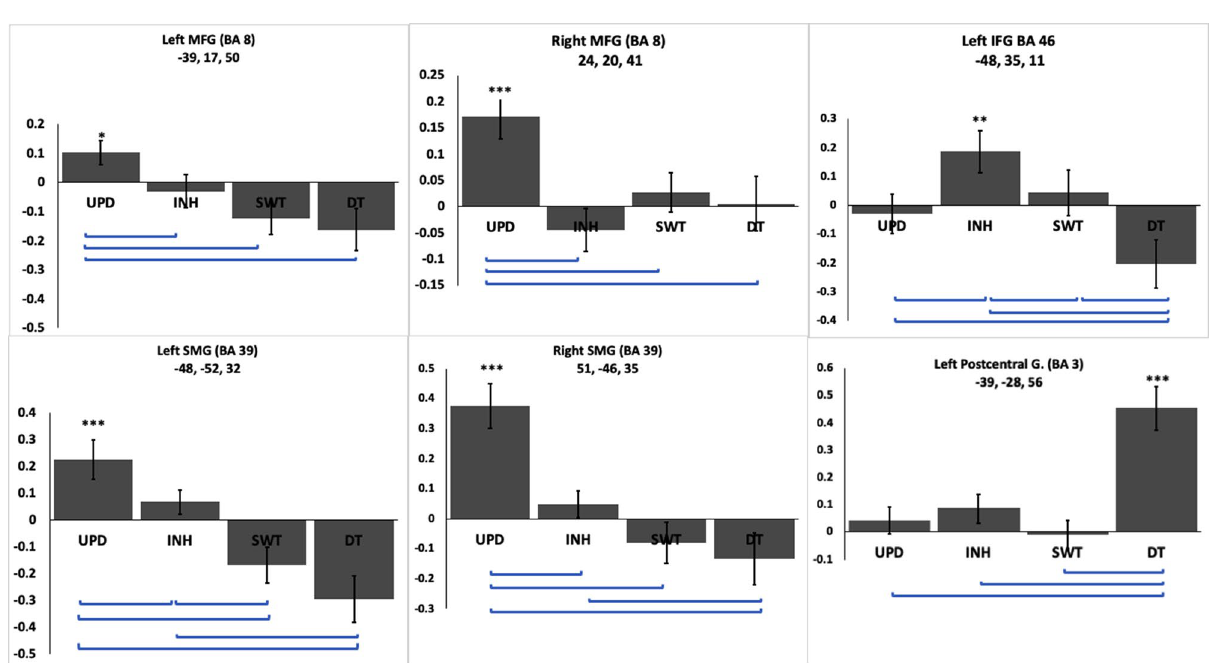
Figure 4. Shown are areas of absolute diversity based on coordinates in Table 2. Asterisks over each bar indicate significant positive activation in the corresponding task *p < 0.05; **p < 0.01; ***p < 0.001. Error bars (SEM) indicate how EFs differentiate from each other. Please note that each graph has a different